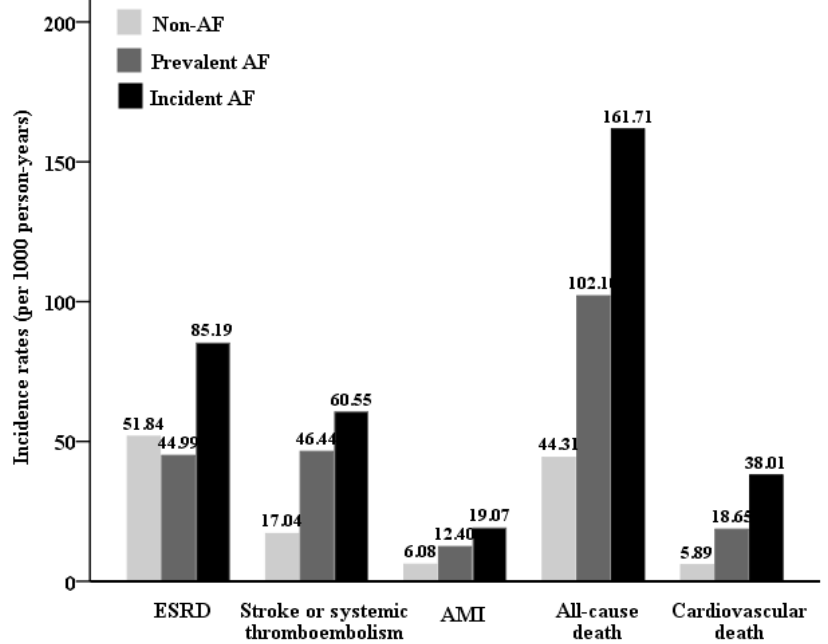
Figure 2. Cumulative incidence rates of study outcomes amongst participants with non-AF, prevalent AF, and incident AF.